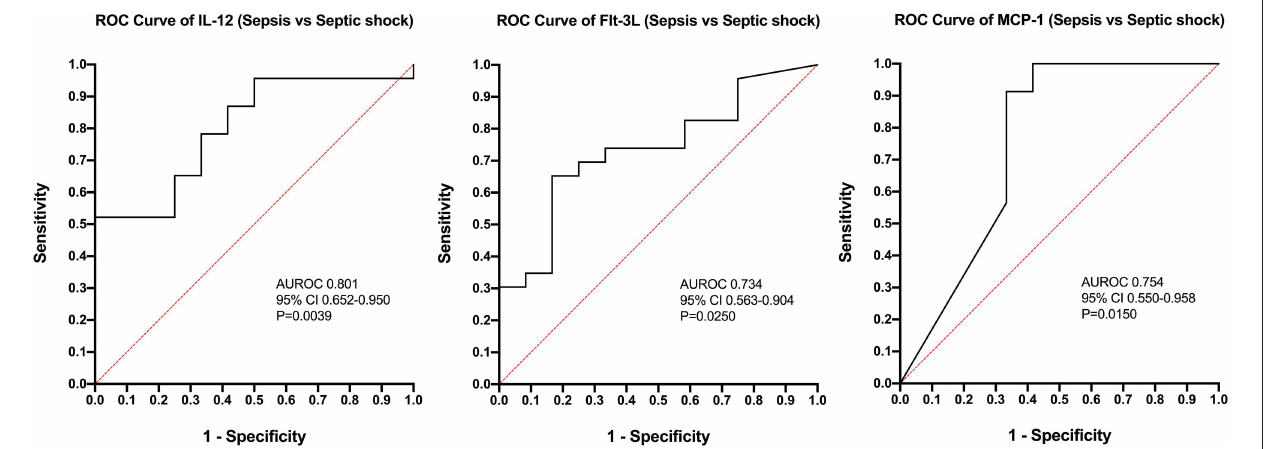
FIGURE 4 | Receiver operating characteristic (ROC) curves for differentiation of cats with septic shock from those with sepsis using measurement of the concentrations of Interleukin-12, FMS-like tyrosine kinase-3 ligand, and MCP-1 monocyte chemoattractant-1. AUROC, area under the ROC curve; CI, confidence interval. TABLE 5 | Multivariable logistic regression model for differentiation of sepsis from septic shock. Variable Model parameter 95% estimate (ln OR)